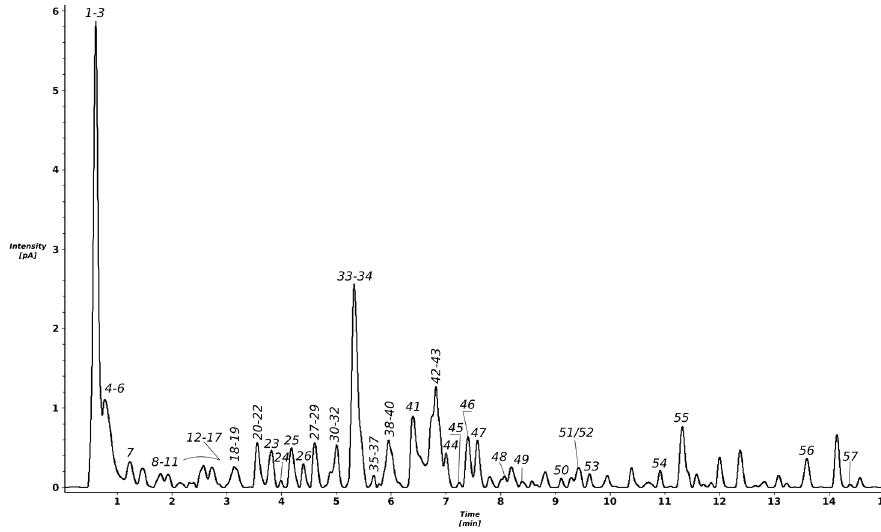
Figure 1. UHPLC–charged aerosol detector (CAD) profile of the T. erecta total methanolic extract.